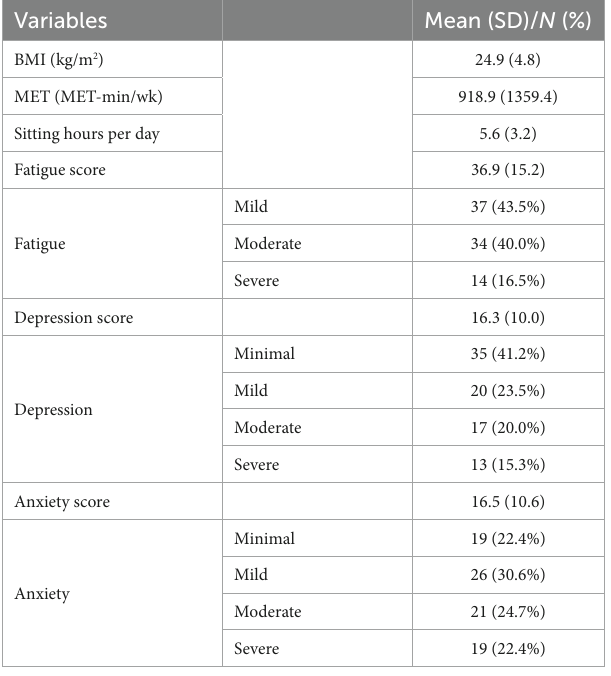
TABLE 1 Baseline characteristics of participants. TABLE 2 Descriptive statistics of